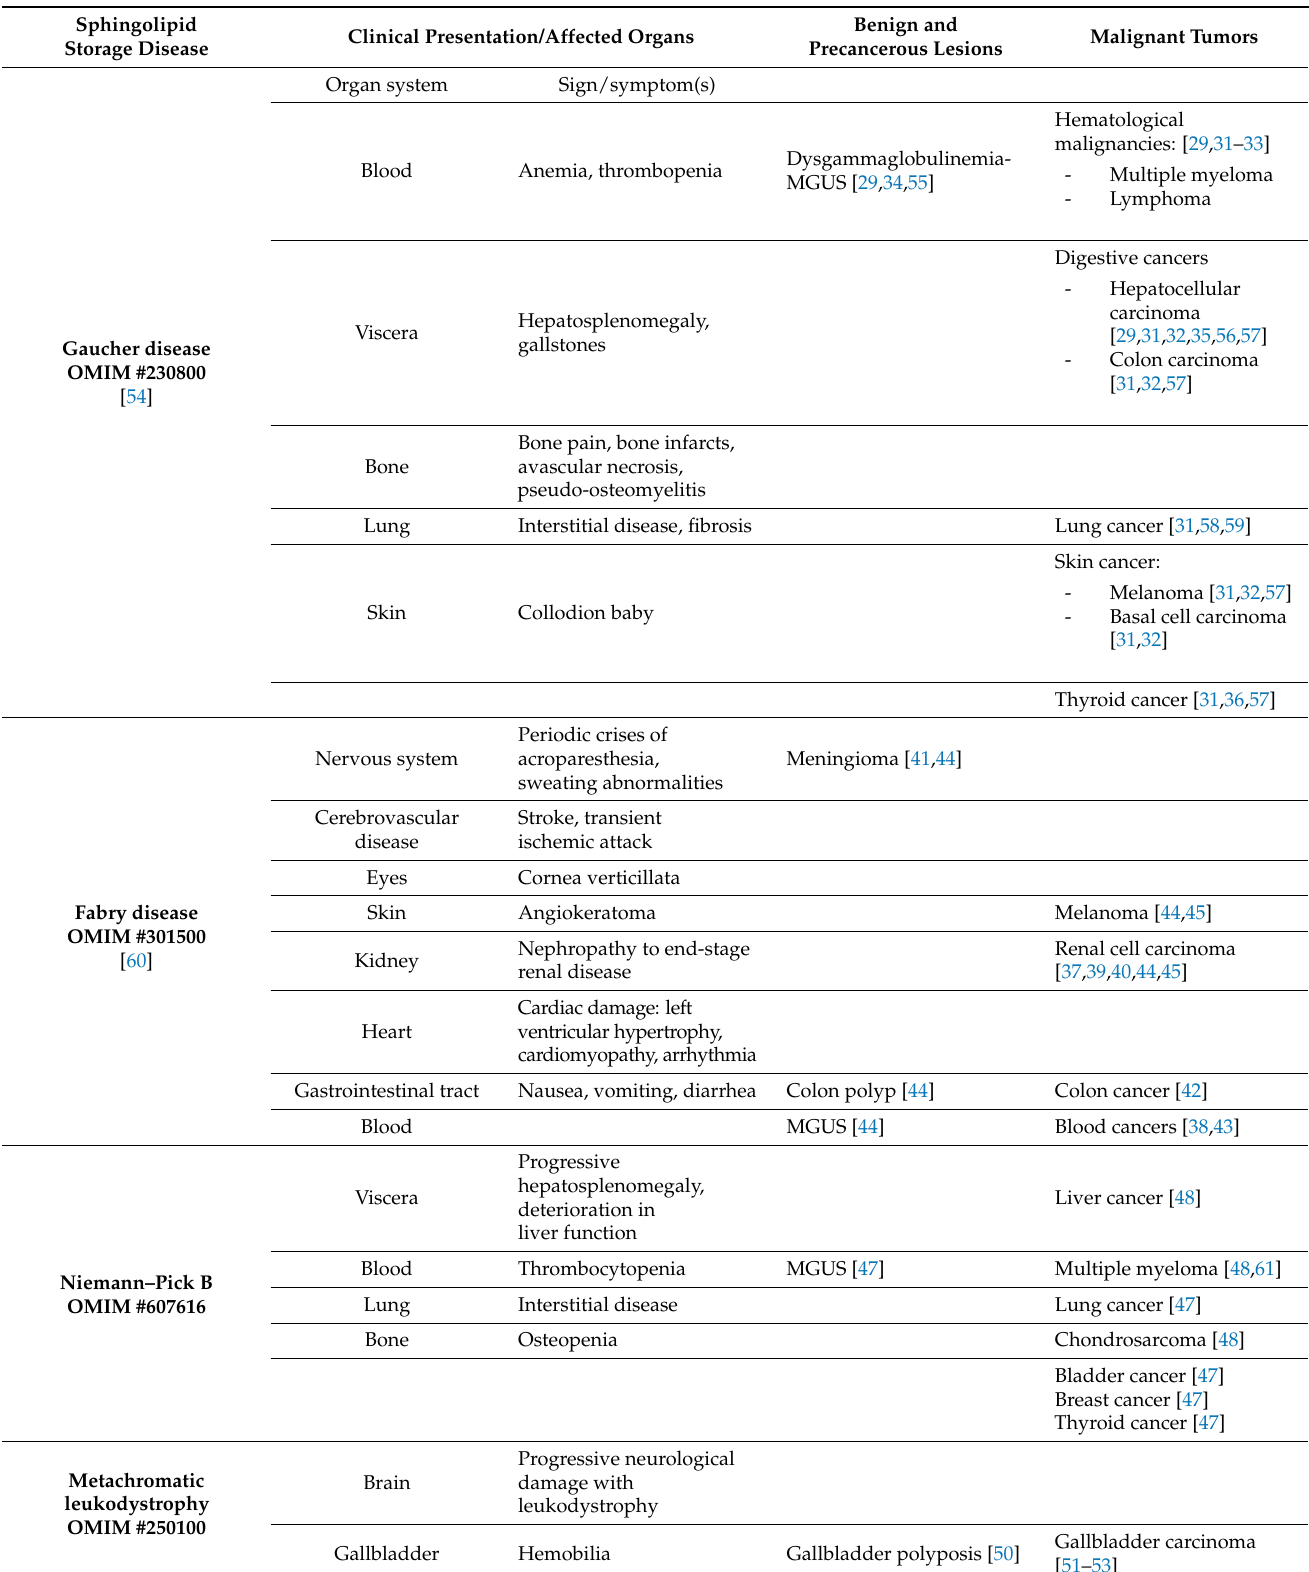
Table 2. Overview of malignancies described in patients affected with Gaucher disease, Fabry disease, Niemann–Pick B disease, or metachromatic